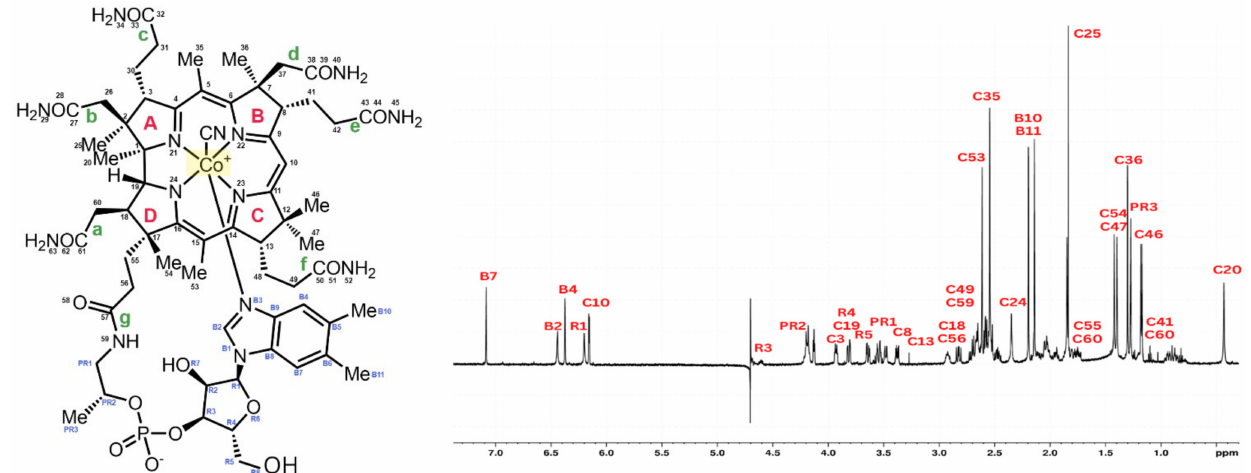
Figure 1. Molecular formula of cyanocobalamin ( left ). 1 H NMR spectrum of cyanocobalamin and identification of all proton peaks ( right ).